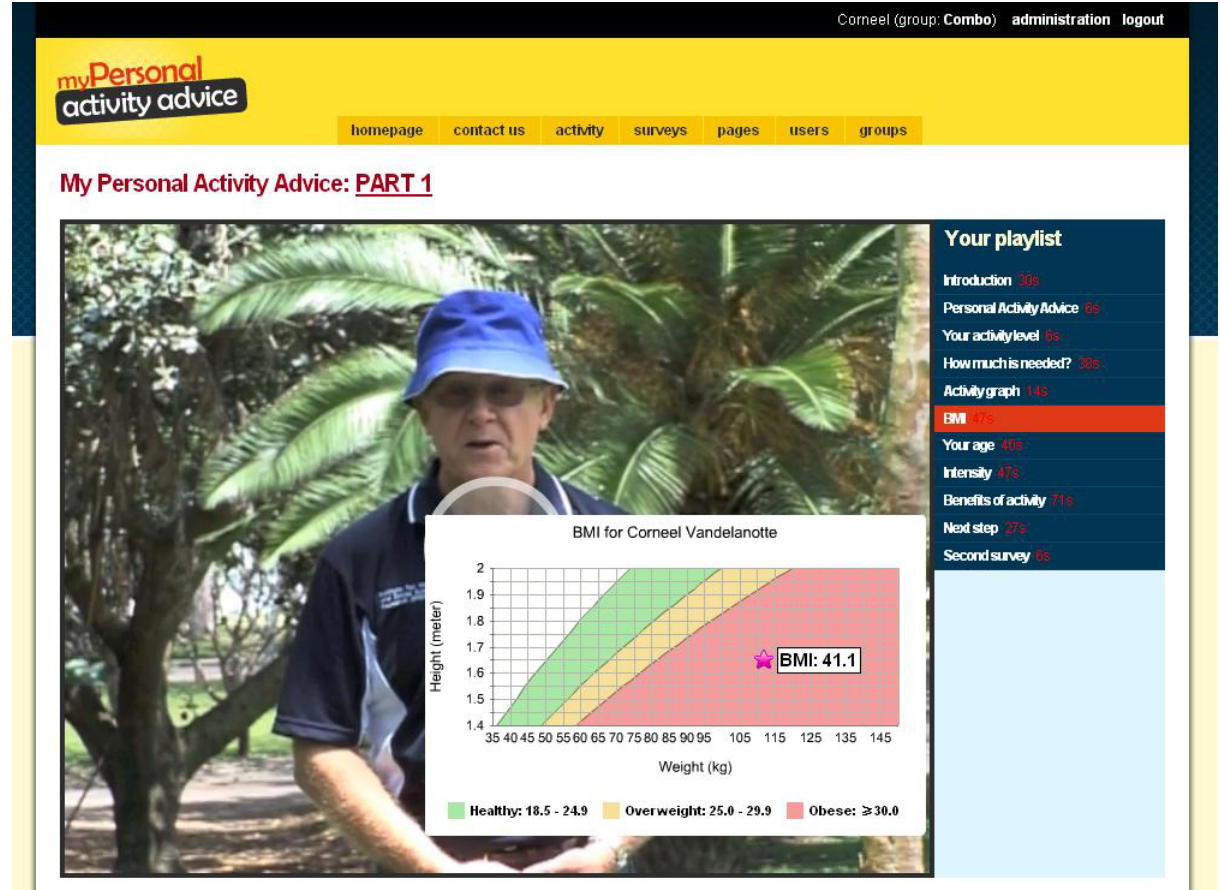
Figure 5. Screenshot of video mode